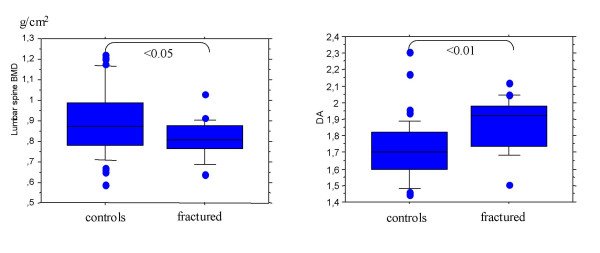
Box plots of lumbar spine BMD and DA. A T-test was used to compare controls and fractured patients.